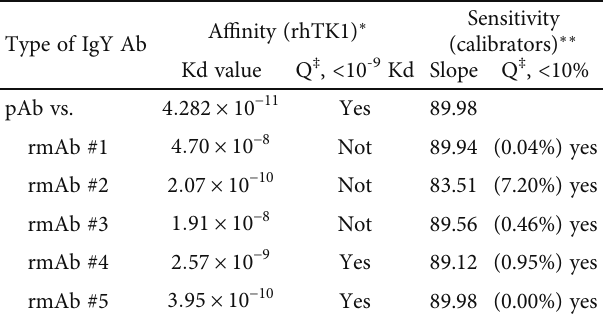
Table 3: Comparative determination of the a ffi nity binding and sensitivity (a) and speci fi city (b) between hTK1-IgY-pAb and the fi ve di ff erent rmAbs (for the method, see Section 2.3.3). (a) Comparison of sensitivity between hTK1-IgY-pAb (pAb)